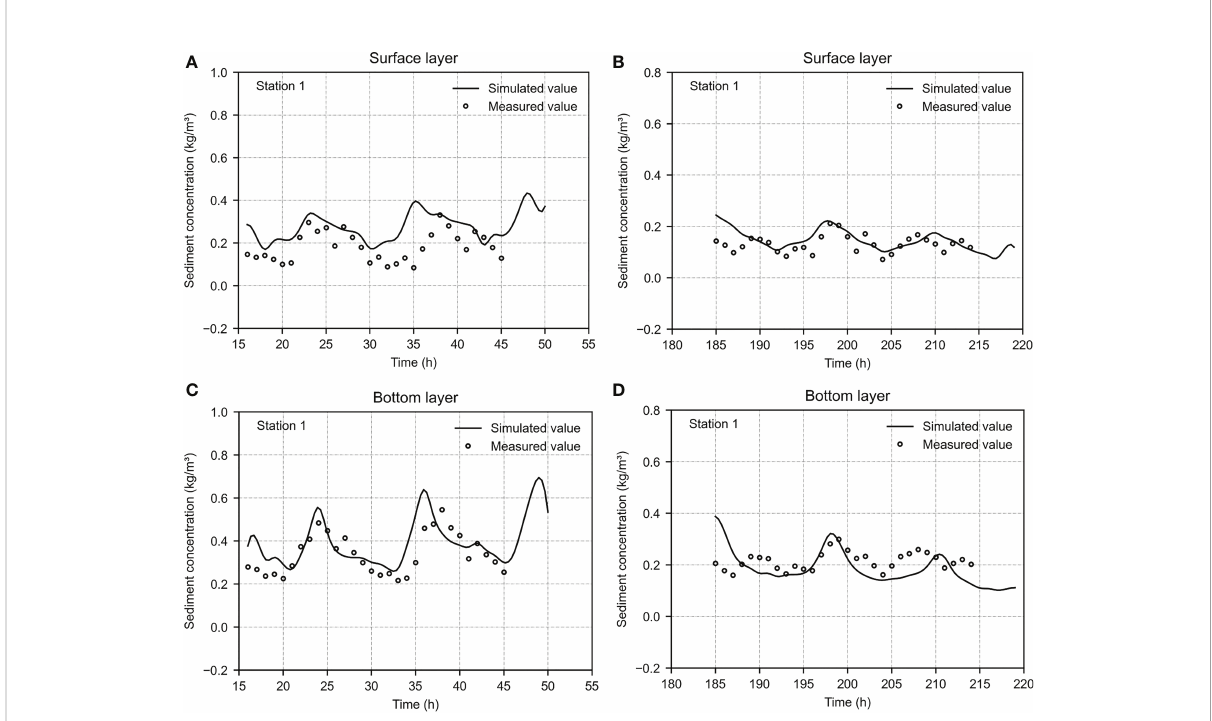
FIGURE 7 Validation of surface & bottom sediment concentration during spring & neap tide at Station 1. (A) Surface sediment concentration at Station 1 during spring tide. (B) Surface sediment concentration at Station 1 during neap tide. (C) Bottom sediment concentration at Station 1 during spring tide. (D) Bottom sediment concentration at Station 1 during neap